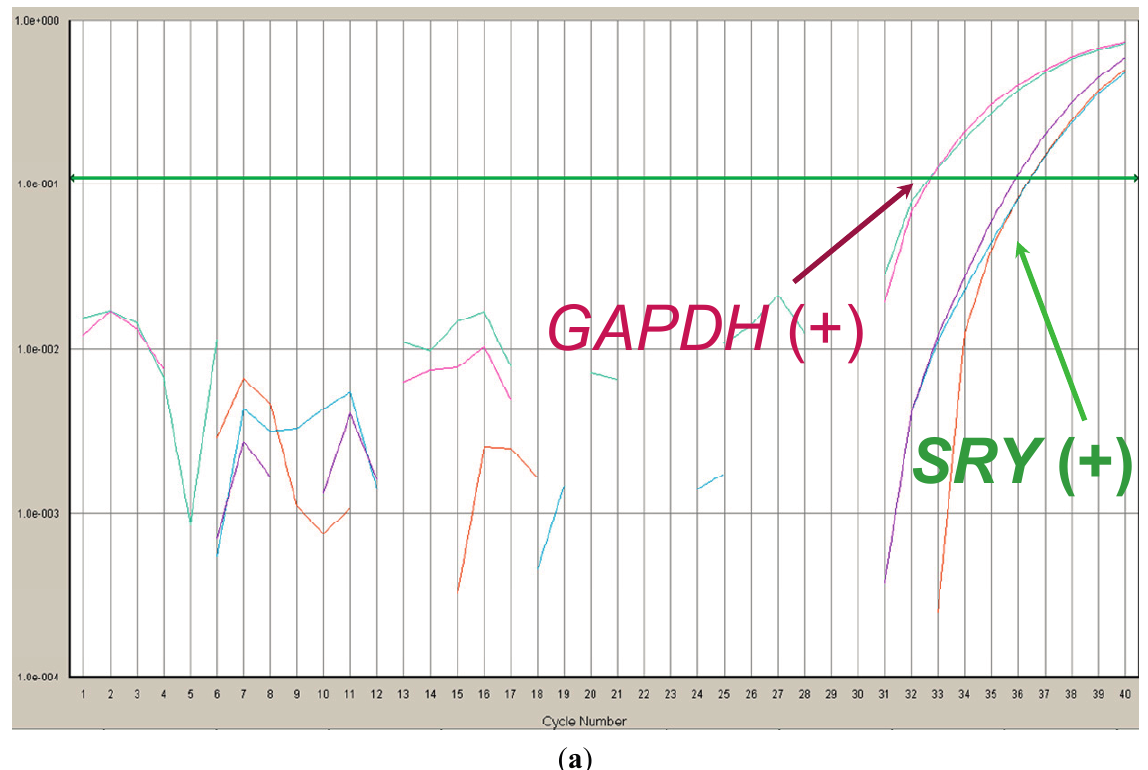
Figure 1. Analysis of SRY and GAPDH genes by Real-Time PCR in ccfDNA collected from maternal blood. Fetal sex determination is based on the presence/absence of the SRY gene. ( a ) Positive amplification for SRY and GAPDH . These results are associated to a male fetus; ( b ) Positive amplification for GAPDH and no amplification of SRY gene are associated to a female